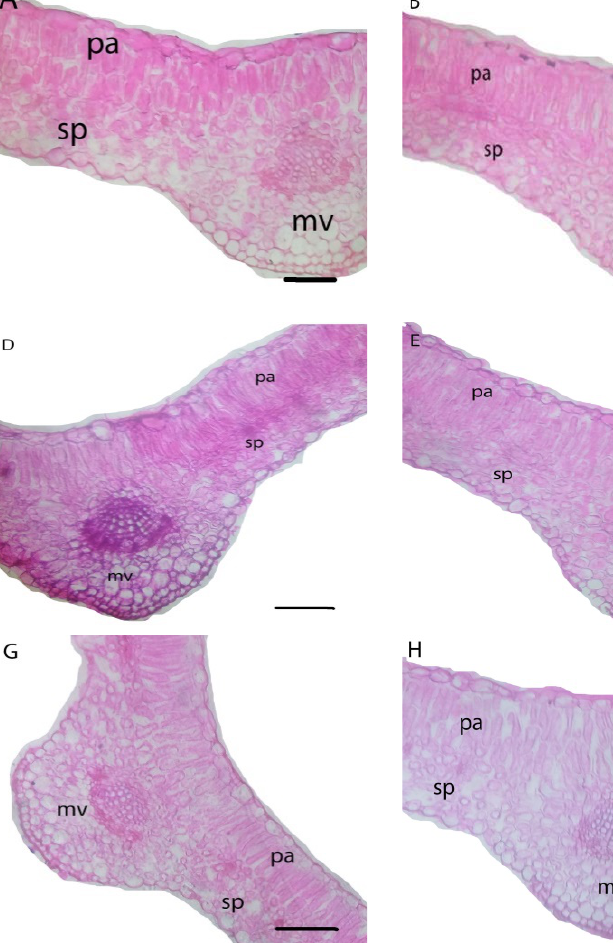
Figure 4. Leaf anatomy of fenugreek plants grown under different irrigation levels and phosphorus nanoparticles treatments. ( A ) dI-00 × cP; ( B ) dI-00 × nP-1; ( C ) dI-00 × nP-2; ( D ) dI-20 × cP; ( E ) dI-20 × nP-1; ( F ) dI-20 × nP-2; ( G ) dI-40 × cP; ( H ) dI-40 × nP-1; ( I ) dI-40 × nP-2; (mv = midvein, pa = palisade tissue and sp = spongy tissue). Scale bar = 140 µ